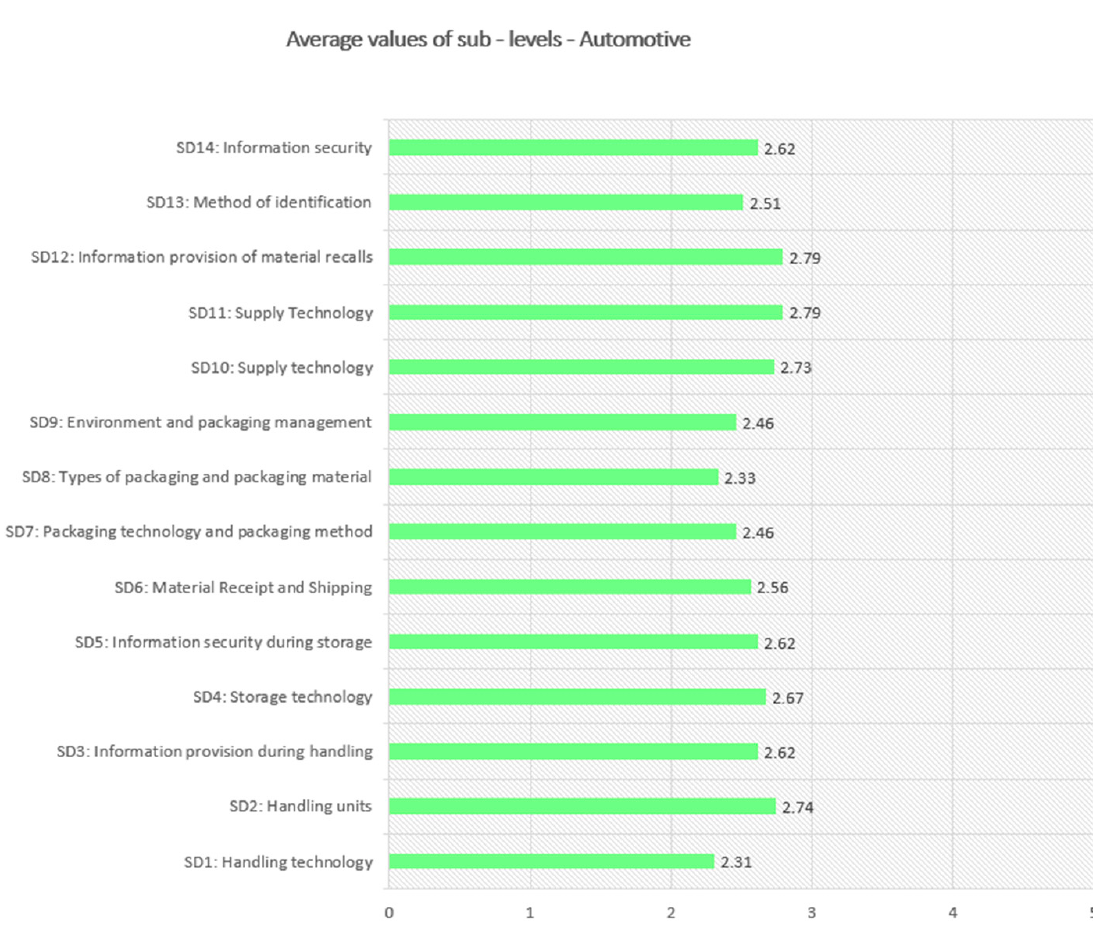
Figure 7. Average values in the automotive sector .